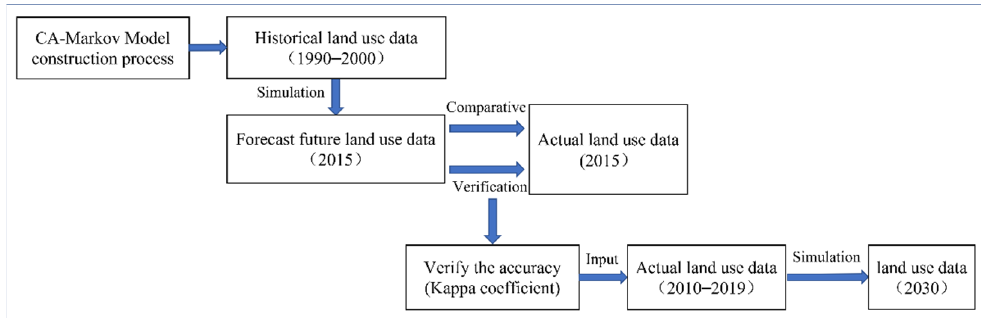
Figure 2. Land use simulation process.